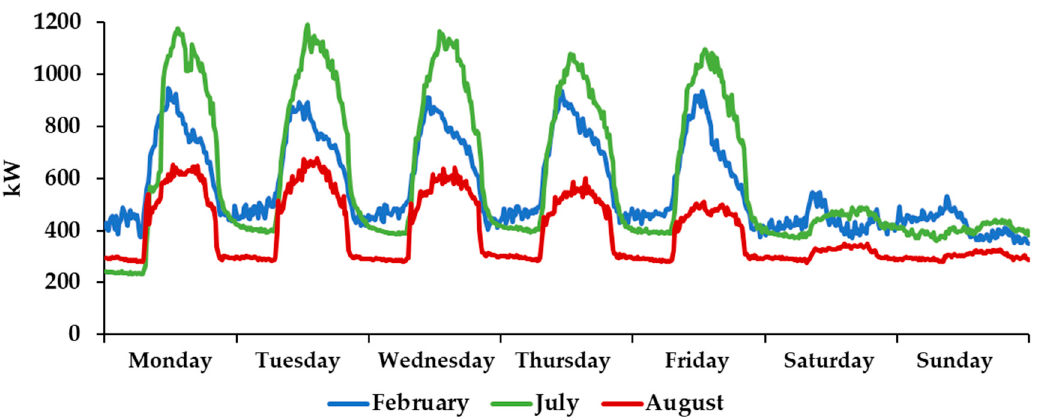
Figure 4. Load profiles during one week in February, July and August.